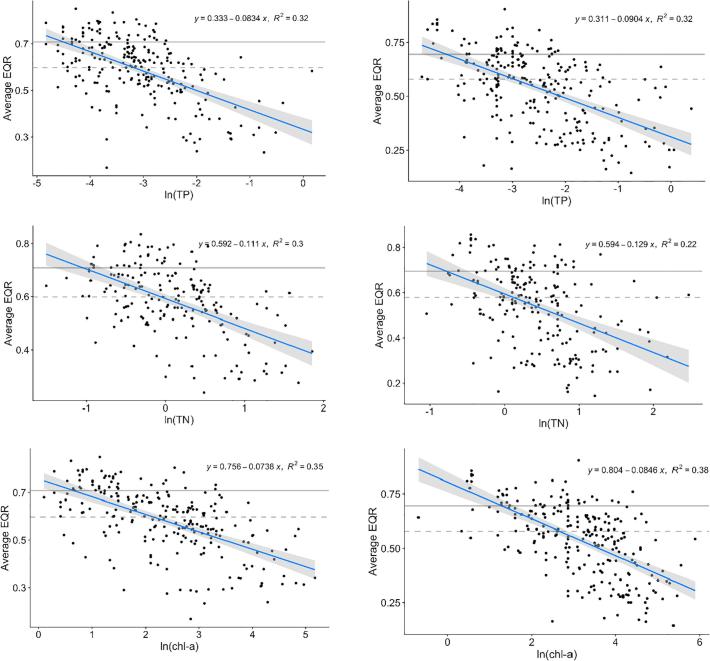
Relationships between log-transformed total phosphorus (TP), chlorophyll-a (chl-a) and average EQR of all Member States after intercalibration for LCB1 (left) and LCB2 (right). Horizontal lines represent the boundaries of ‘good’ and ‘moderate’ (dashed) or ‘high’ and ‘good’ (solid) ecological status.